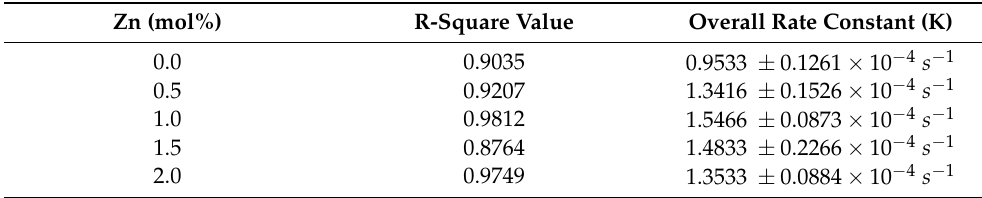
Table 3. Overall rate constants for photocatalytic degradation of MB under direct sunlight with undoped, 0.5, 1.0, 1.5, and 2.0 mol% Zn-doped TiO 2 as photocatalysts. Zn (mol%) R-Square Value